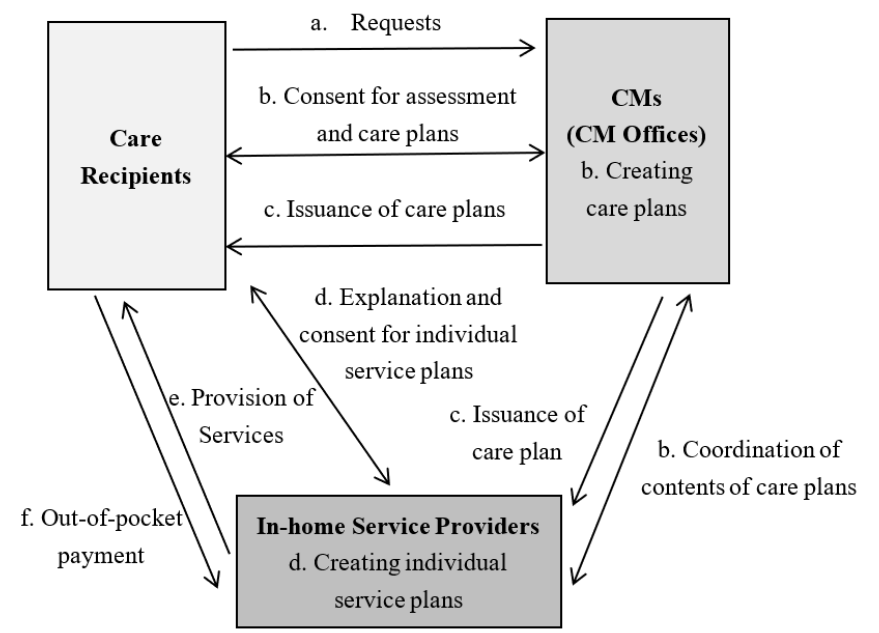
Figure 3. Workflow of CMs regarding in-home nursing care. Source: Ministry of Health, Labour and Welfare. Instructions for Care Managers, 2023 [11].